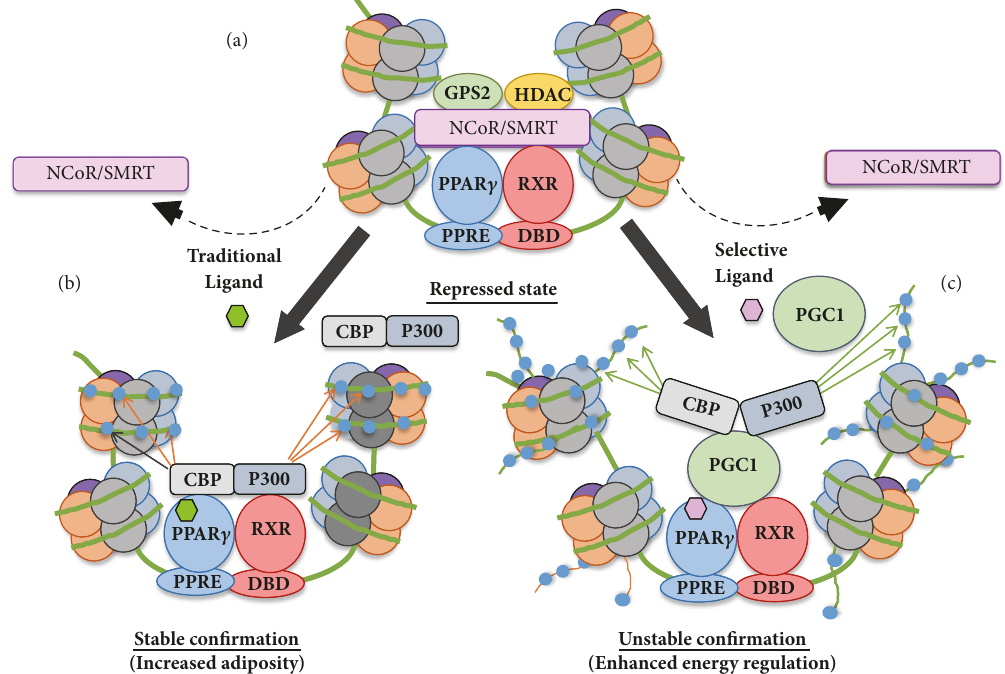
Figure 5: PPAR 𝛾 receptor (a) is in the repressed state due to the transcriptional cofactor inhibitors NCoR/SMRT binding with PPAR 𝛾 and preventingthe transcription of target genes.Whentraditional (full agonist,(b))or selectiveagonist(c)changes theconfirmationof the PPAR 𝛾 receptor and corepressors NCoR/SMRT come off. Traditional agonists (full agonist) such as rosiglitazone or pioglitazone promote a stable confirmation of the PPAR 𝛾 -RXR confirmation with coactivatorsCBP/P300. However, selective agonists can induce an unstable confirmation of the PPAR 𝛾 complex and allow alternative interactionswith nontraditional coactivators,potentially PGC-1 𝛼 , thus inducing alternative gene